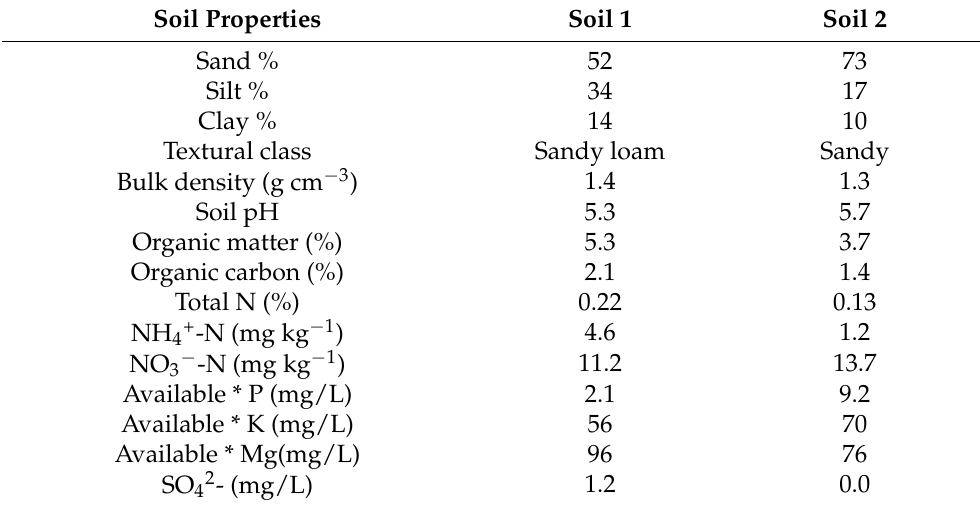
Table 1. The initial physical and chemical characteristics of the soil used in the incubation